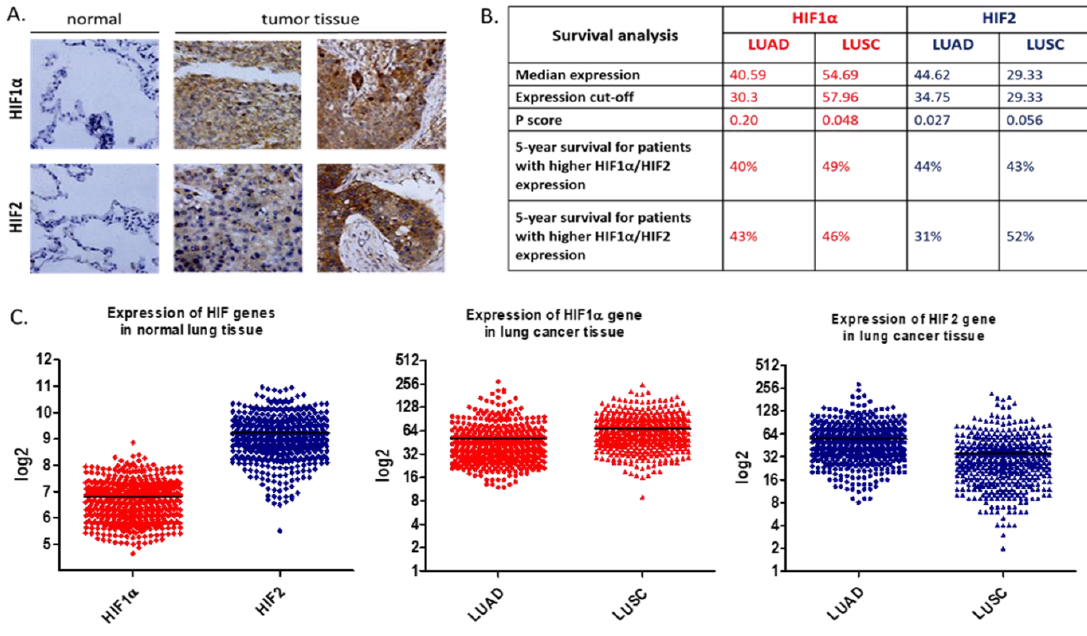
Figure 4. ( A ) . HIF-1 α and HIF-2 α expression in non-small cell lung cancer (NSCLC) tumors. ( B ) . Survival analysis of lung adenocarcinoma (LUAD, n = 500) and lung squamous cell carcinoma (LUSC, n = 494) patients. Median expression refers to the median FPKM value calculated based on the gene expression (FPKM) data from all patients in this dataset. Expression cut-off: based on the FPKM value of each gene, patients were classified into two groups, and association between survival and gene expression (FPKM) was examined. The best expression cut-off refers the FPKM value that yields maximal difference with regard to survival between the two groups at the lowest log-rank P-value. P score: Log-rank P value for Kaplan–Meier plot showing results from analysis of correlation between mRNA expression level and patient survival. Five-year survival for patients with higher or lower expression than the expression cut-off. ( C ) . Expression of HIF-1 α and HIF-2 α in lung adenocarcinoma (LUAD) and lung squamous cell carcinoma (LUSC) tumor tissue derived from patients and healthy controls. All data presented in Figure 3 were collected from The Human Protein Atlas version 20.0 database